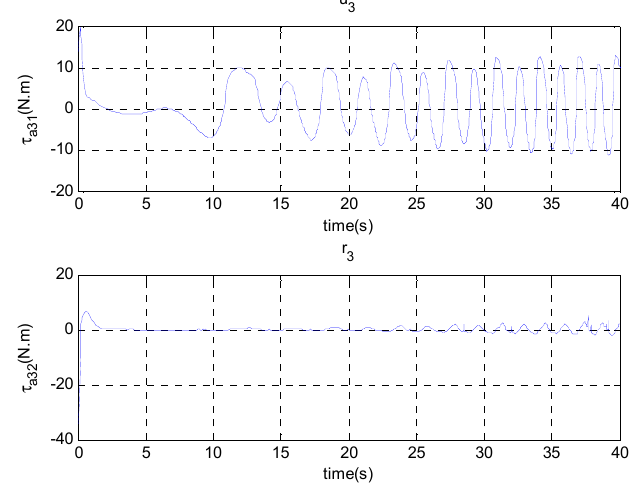
Figure 14. Applied input control of the third follower in Example 2.